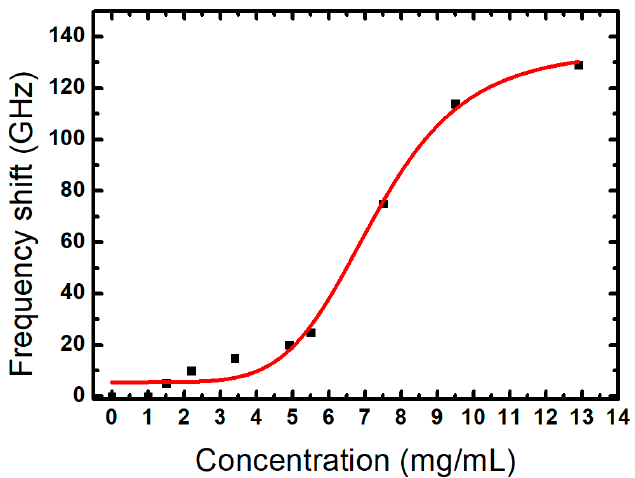
Figure 6. The frequency shift of the resonant frequency of the terahertz transmission as a function of the galactose concentration.